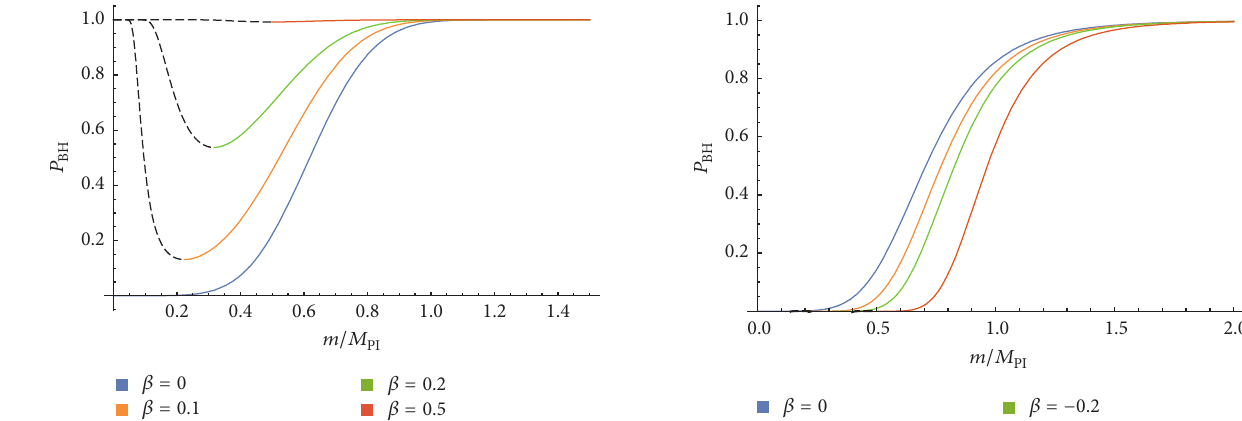
Figure 4: Analytic approximation of the probability 𝑃 BH (𝑚) for a particle to be a black hole versus mass of the particle for decreasing values of the free parameter 𝛽